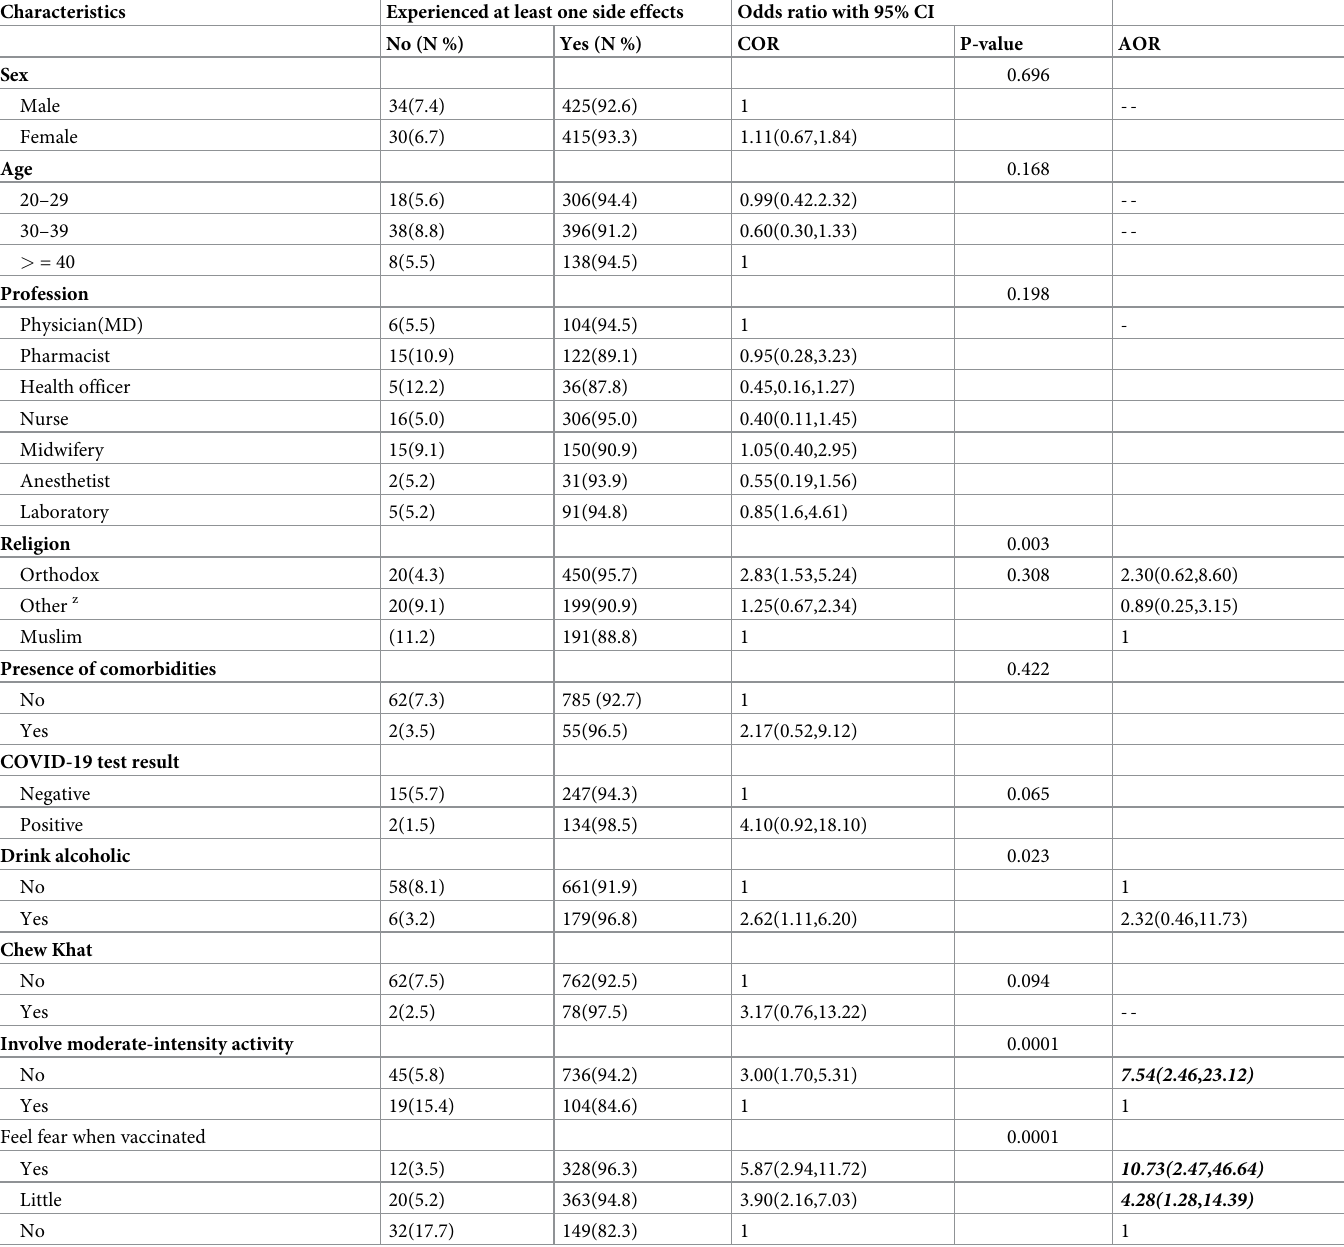
Table 5. Associated factors with post COVID-19 vaccination side effects among the participants for the study of post COVID-19 vaccination evaluation in central Oromia region Ethiopia, 2021.